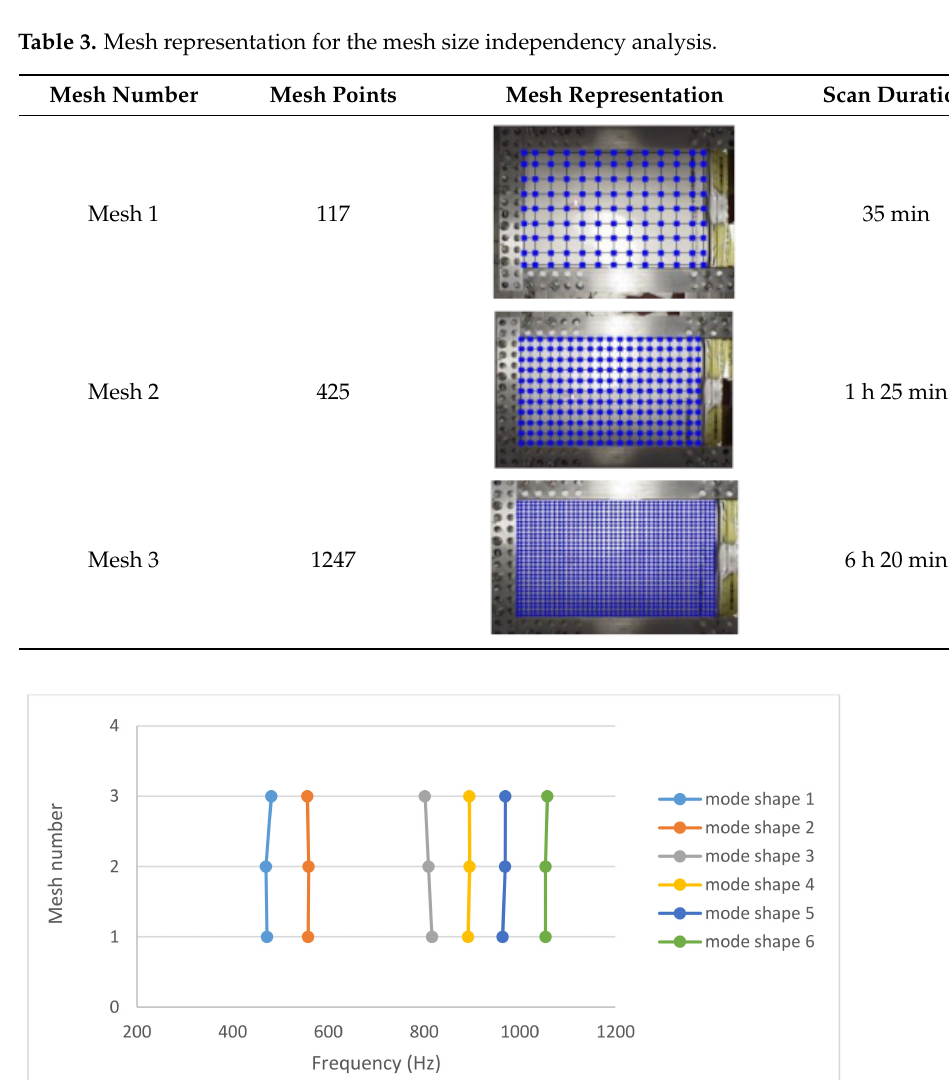
Figure 5. Each mode shape frequency for the three mesh